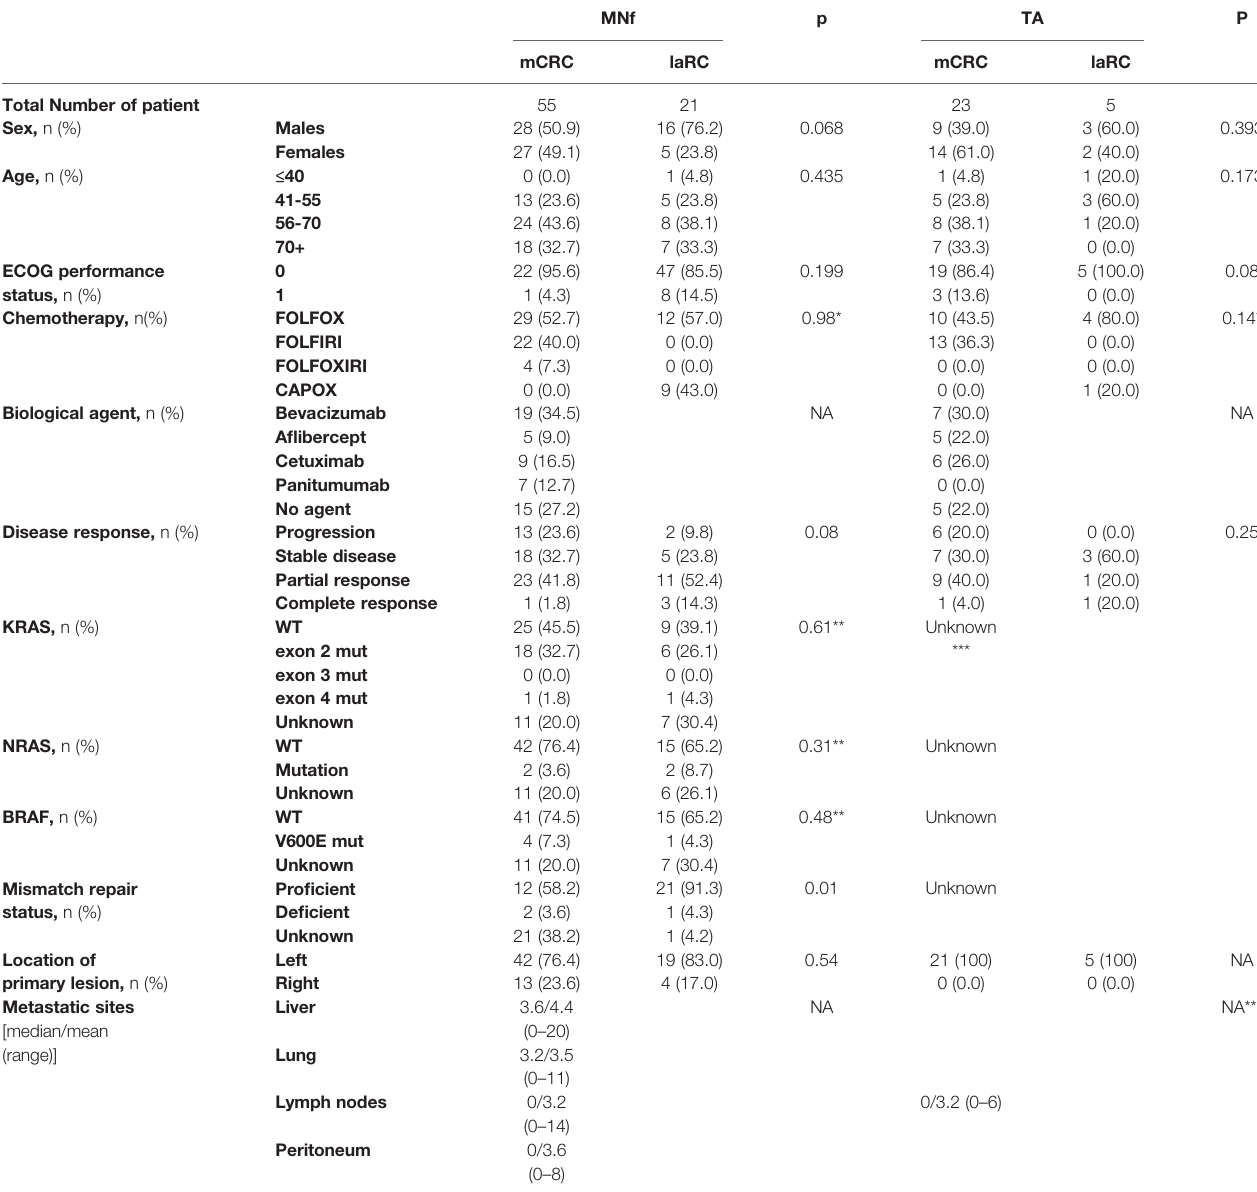
TABLE 1 | Patient characteristics for MNf and TA groups are presented [sex, age, ECOG performance status, chemotherapy, biologic agent, disease response based on the RECIST criteria, KRAS status, NRAS status, BRAF status, mismatch repair (MMR) status, location of the primary lesion, number of metastatic sites]. MNf p